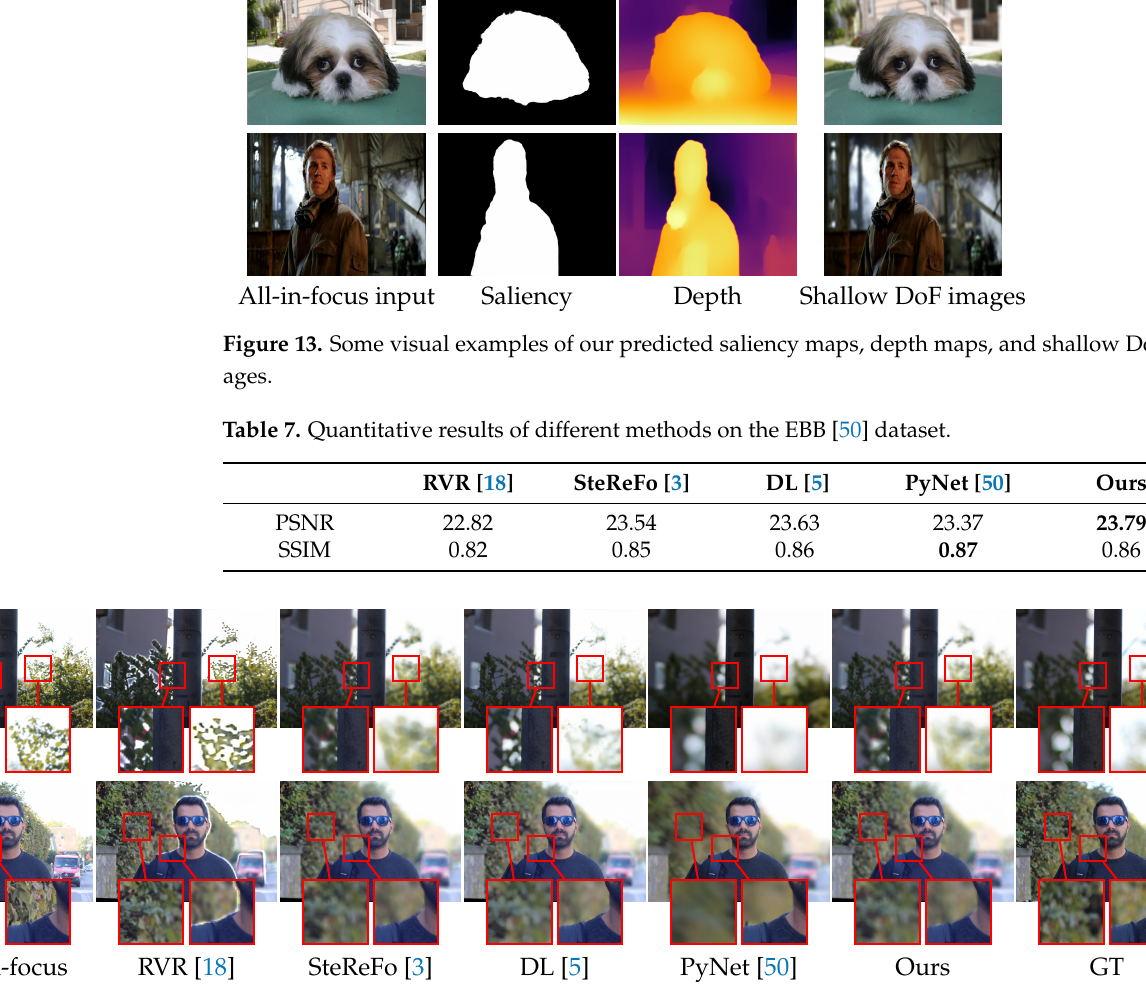
Figure 14. Qualitative results on the EBB dataset. Best viewed zoomed in